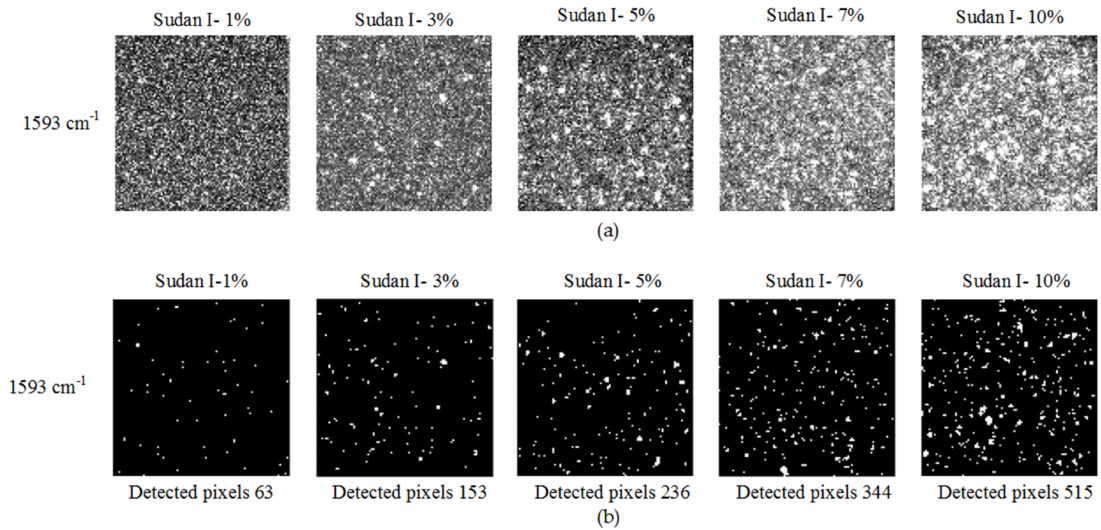
Figure 4. ( a ) Hyperspectral Raman images of curry powder-Sudan I mixture samples; ( b ) binary detection images at 1593 cm − 1